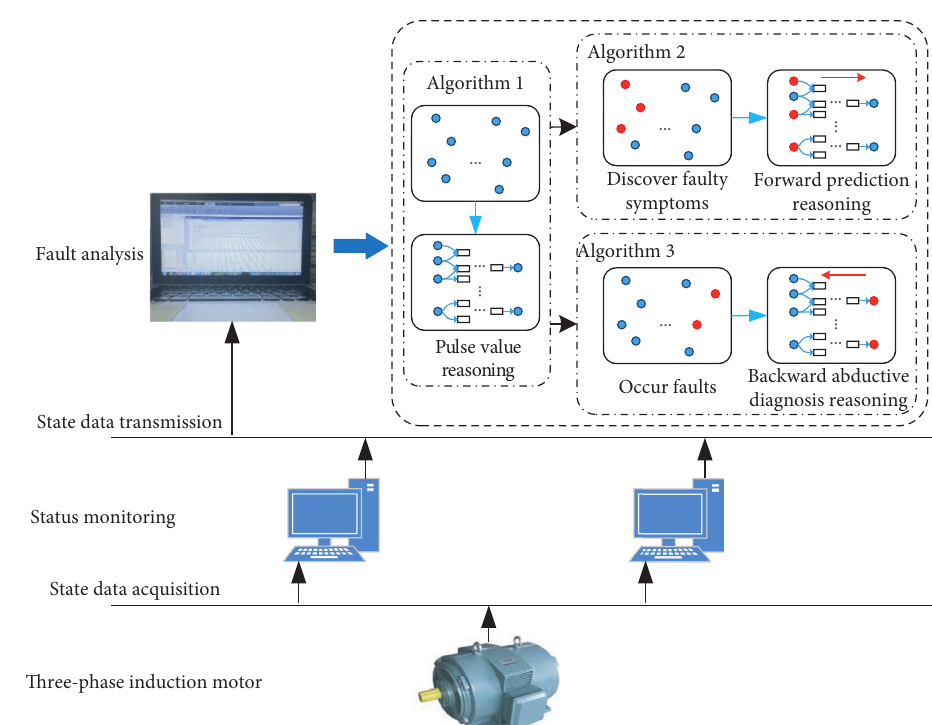
Figure 5: A diagrammatic sketch of the application scenario for the proposed